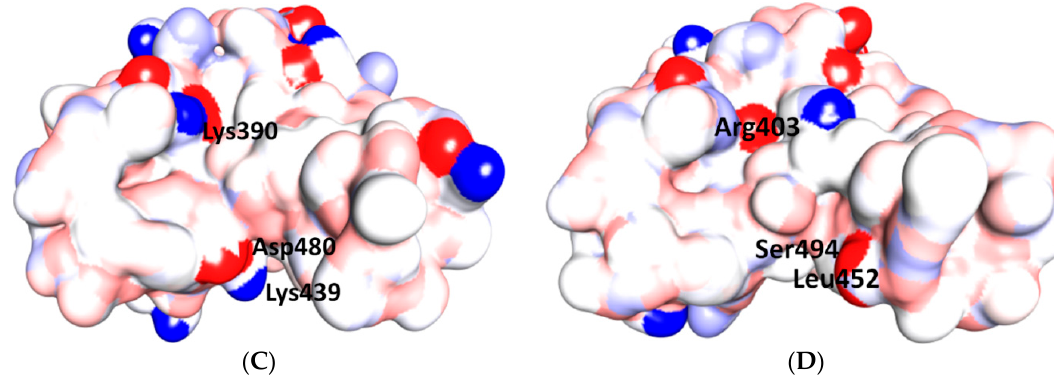
Figure 6. Di ff erences of shallow pit in the ridge region of RBD for SARS-CoV and SARS-CoV-2, and its binding with hesperidin in SARS-CoV-2. ( A ) Two-dimensional structure of hesperidin and its surrounding interactions with the SARS-CoV-2 RBD. ( B ) Hesperidin has been predicted to lie on the middle shallow pit of the surface of the RBD of the S protein, where the dihydroflavone part of the compound lies parallel with the β 6 sheet of the RBD. The sugar moiety is inserted into the shallow pit in the direction away from ACE2, where a few hydrophobic amino acids, including Tyr449, Try453, Leu455, Phe456, Phe490, Try489, Try495 and Tyr505 (corresponding to Tyr436, Tyr440, Tyr442, Leu443, Trp476, Tyr475, Tyr481 and Tyr491 in SARS-CoV) form a relatively hydrophobic shallow pocket to contain the compound. Hydrogen-bonding interactions have been predicted between Tyr453, Ser494, Gln409, Tyr449, Arg403 (corresponding to Tyr440, Asp480, Gln396, Tyr449 and Lys390 from SARS-CoV) and the compound. Tyr453 and Tyr449 are among the critical amino acids. ( C , D ) in the space-filling models of the S protein in SARS-CoV (left) and SARS-CoV-2 (right), the shallow pit is apparent (Tyr453 and Tyr449 are among the critical amino acids). The hydrophobic cleft is apparently similar in both viruses; the di ff erences are mainly located at the gates of this cleft, where Asp480 and Lys439 at one entrance in SARS-CoV are replaced by Ser494 and Leu452 in SARS-CoV-2, while Lys390 at the other entrance in SARS-CoV is replaced by Arg403 in SARS-CoV-2. These changes may a ff ect the binding a ffi nities of proposed drugs with SARS-CoV and SARS-CoV-2. It has been reported that the electrostatic potential observed for SARS-CoV-2 is more positive than that for SARS-CoV, which is consequently considered to result in a greater electrostatic interaction between ACE2 and SARS-CoV-2. This could be explained by the replacement of the negatively charged amino acid Asp by a neutral Ser (Asp480 to Ser494) [59]. Three-dimensional models were created using Discovery Studio (version 2.5.5, Biovia, San Diego, CA, USA).